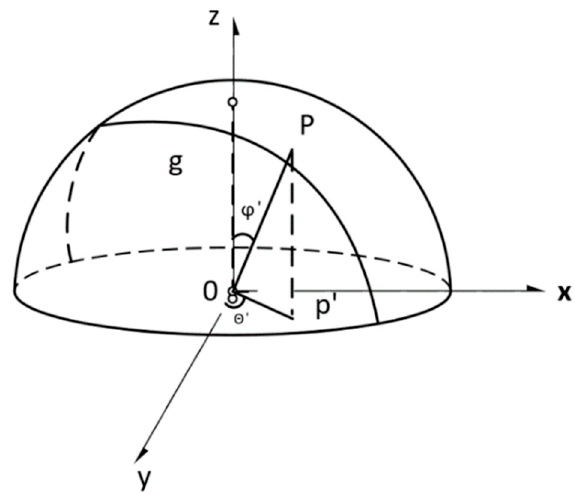
Figure 1. The principle of canopy hemispherical photography (CHP).